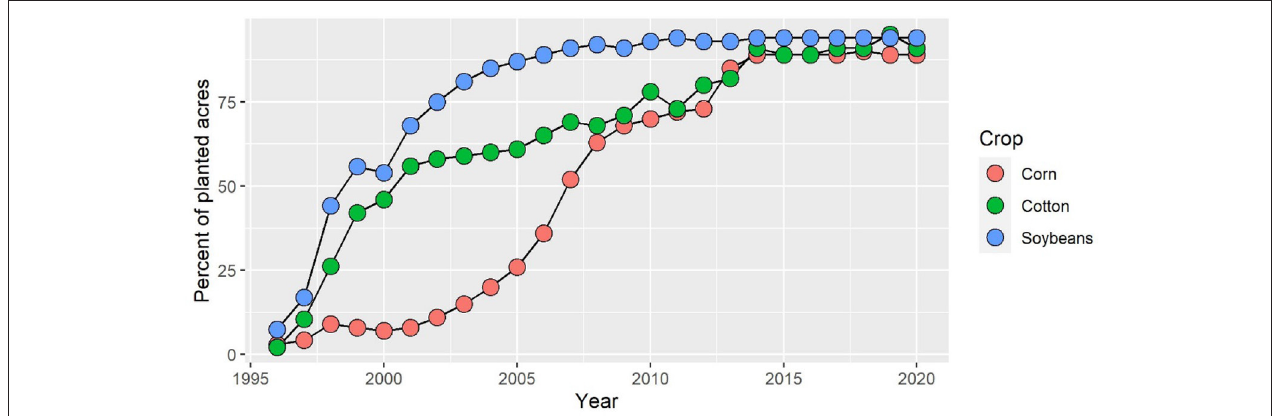
FIGURE 1 | Adoption of herbicide-tolerant crops in the United States since the 1990’s. The crop data indicate herbicide-tolerant varieties. Source: USDA, Economic Research Service using data from the 2002 ERS report, Adoption of Bioengineered Crops (AER-810) for the years 1996–99 and National Agricultural Statistics Service (annual) June Agricultural Survey for the years